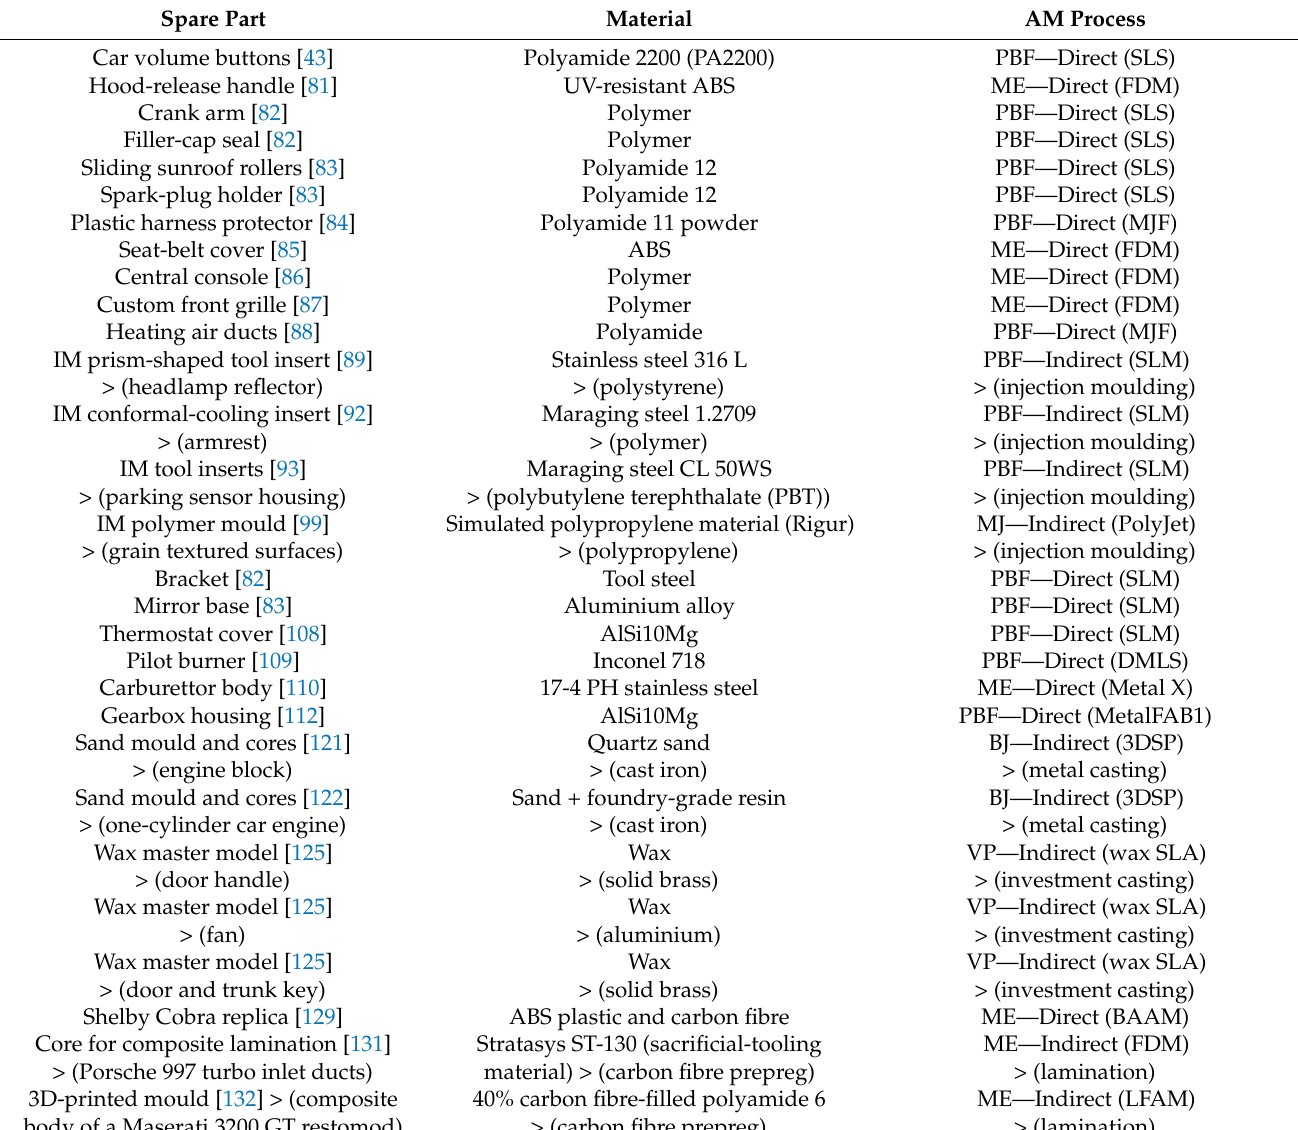
Table 1. Automotive spare-part reconstruction: reproduced